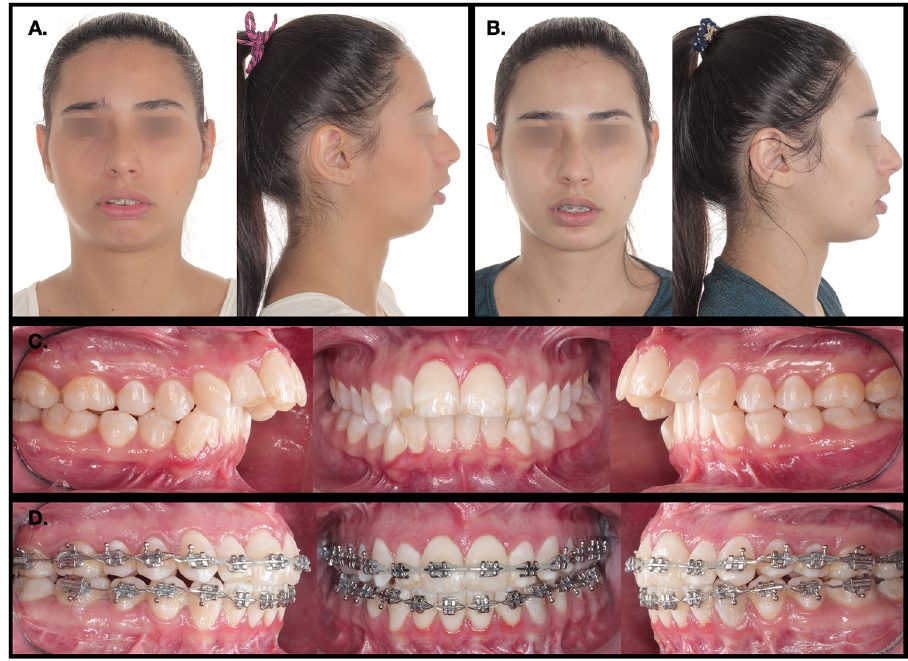
Fig. 5. Patient one: A, C. Presurgical (Front and right pro fi le view) and occlusion (Left, Front and right view), B, D. Postsurgical (Front and right pro fi le view) and occlusion (Left, Front and right view) 1 year postsurgical. *Osteotomy Lefort I, BSSOM, osteotomy chin, and meniscopexy